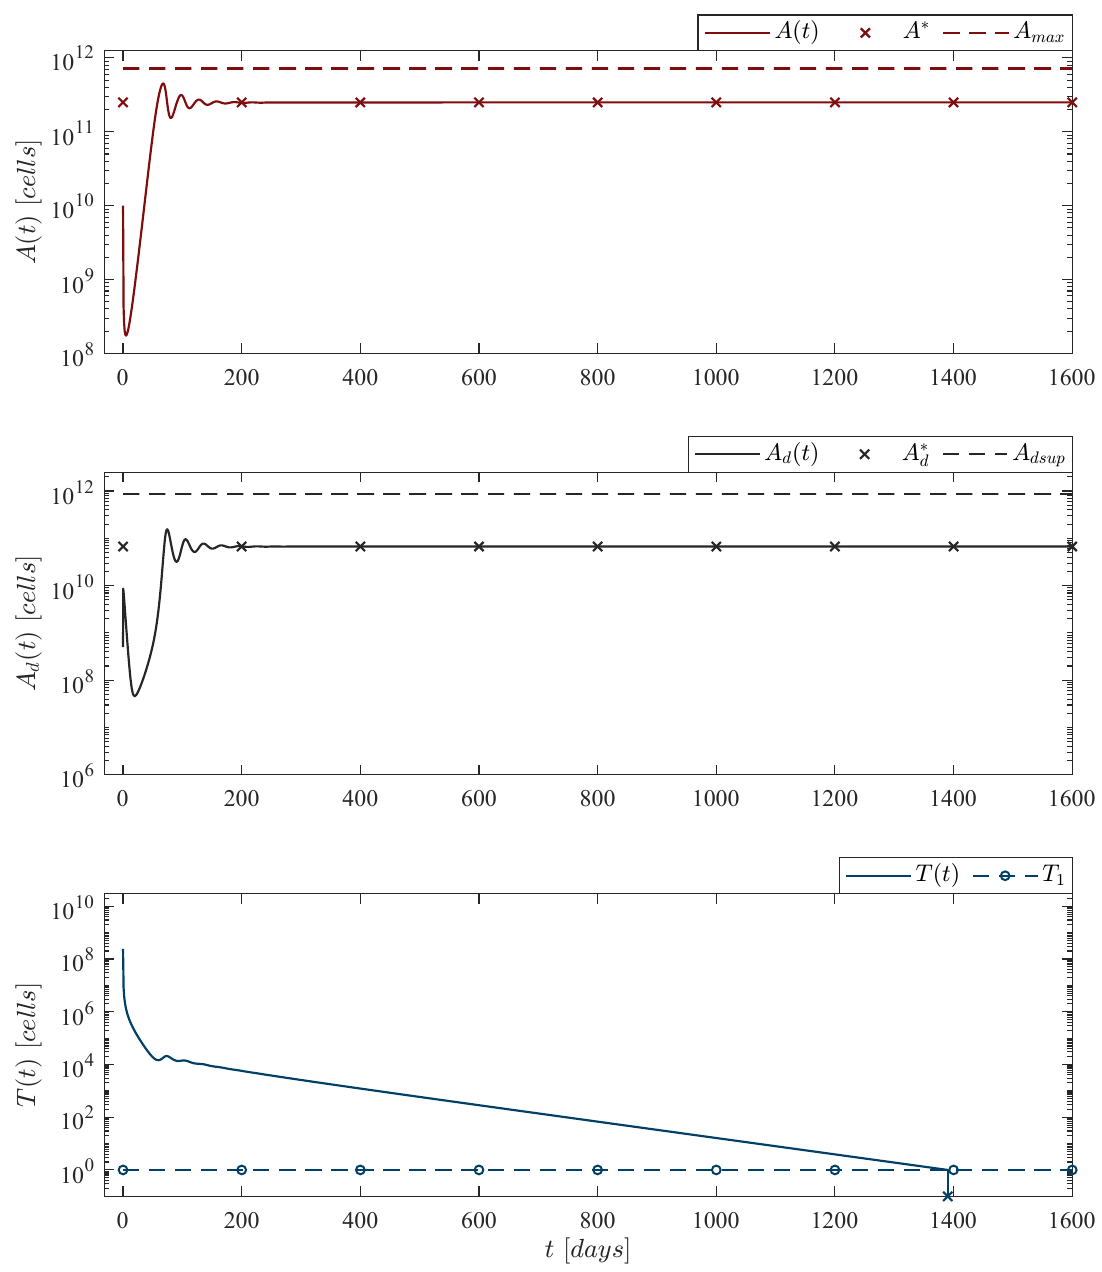
Figure 3. CAR-T cells depletion case. Numerical simulations allow us to illustrate that this phe- nomenon arises when the mitosis/activation rate ( ρ T ) of CAR-T cells is below a threshold directly related to the death rates of both leukemia ( µ A ) and CAR-T cells ( µ T ) , and the dissolution rate of dead leukemia cells ( µ d ) as given by condition (6). The upper panel shows that there is almost a 2log- kill of leukemia cells due to the treatment. However, as CAR-T cells are eventually depleted, the leukemia concentration ends as the ‘no treatments case’, i.e., 50,000 cells/µL. For this case, param- eter values are set as follows: ρ A = 0.1680, ρ T = 2.5714 × 10 − 13 , µ T = 1/14, and α T = 1.2560 × 10 − 7 by Equation